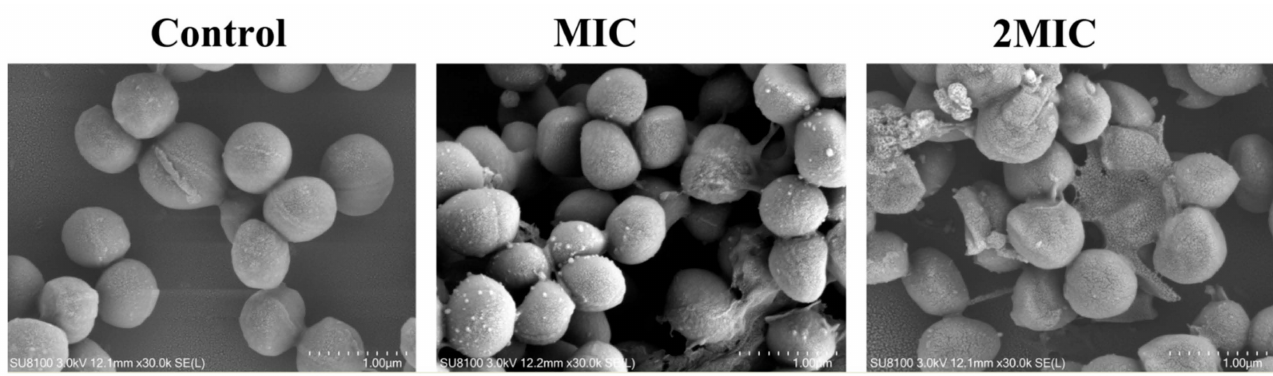
Figure 4. Scanning electron microscope observation of the effect of shikonin on the cell morphology of strain ATCC29213.